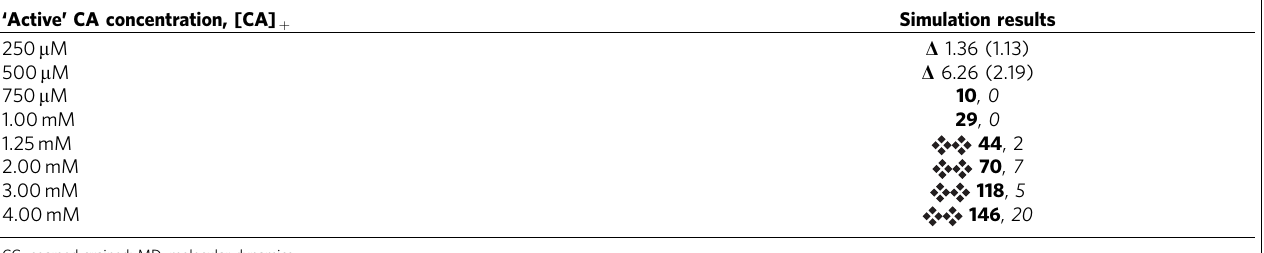
CG, coarsed-grained; MD, molecular dynamics. Triangles( D